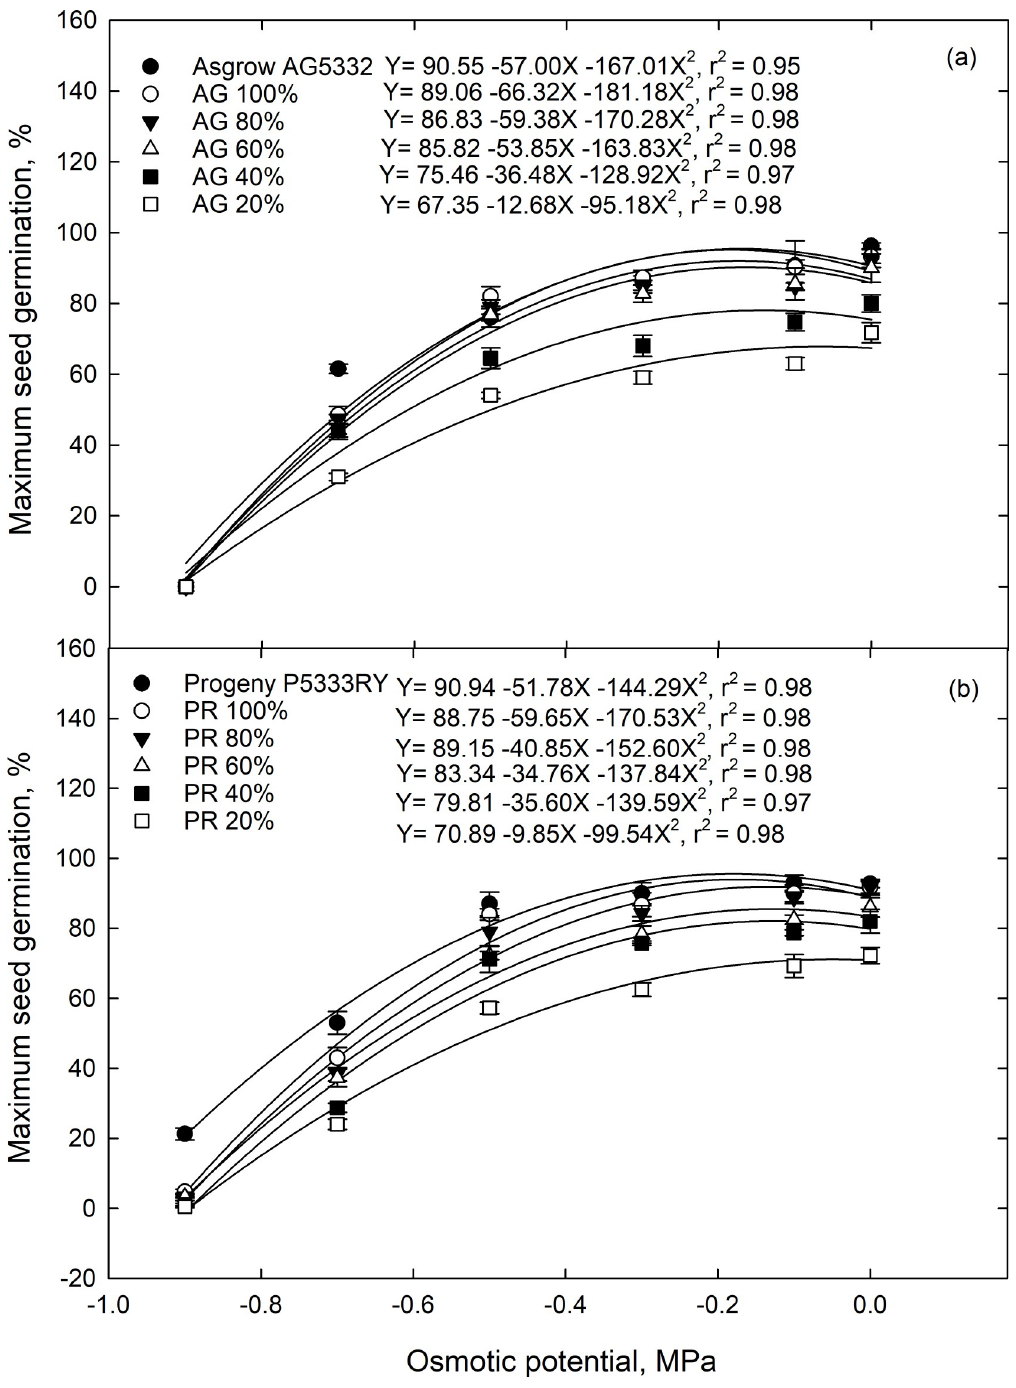
Fig 3. Maximum germination of soybean seed from the F1 generation as a function of osmotic potential. F1 seed was collected from the soybean cultivar (a) Asgrow AG5332 and (b) Progeny P5333RY after exposure to drought stress treatemnts of y including replacement of 100, 80, 60, 40, and 20% of the evapotranspiration demand. Symbols represent the mean of four replications, while bars represent the standard error. Lines are the best fit of a quadratic function.